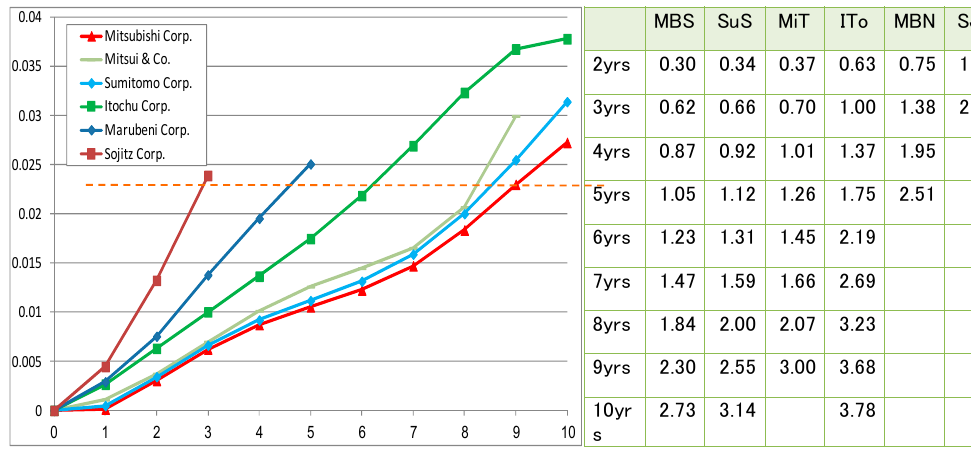
Figure 14. TSDPs of six firms in the trading industry and table of DPs. MBS, Mitsubishi; SuS, Sumitomo; Mit, Mitsui; ITo, Itochu; MBS, Marubeni; SJT, Sojitz.